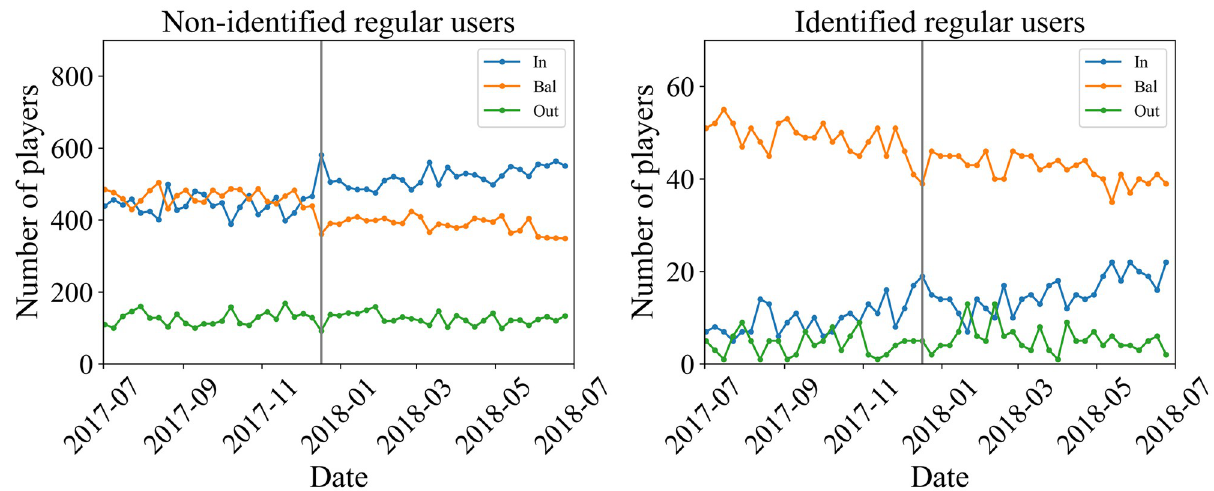
Fig 8. Number of non-identified (left) and identified (right) regular In-, Bal-, and Out-players for Bitcoin. In-, Bal-, and Out-players are plotted in blue, orange, and green, respectively. The gray vertical line represents the week that contains the day of the peak.